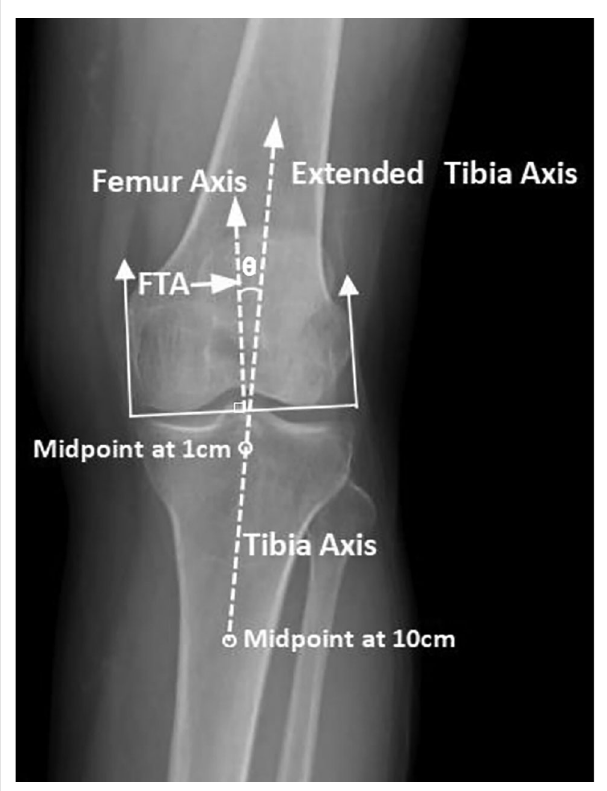
FIGURE 2 | Measurement of femorotibial alignment with a short knee